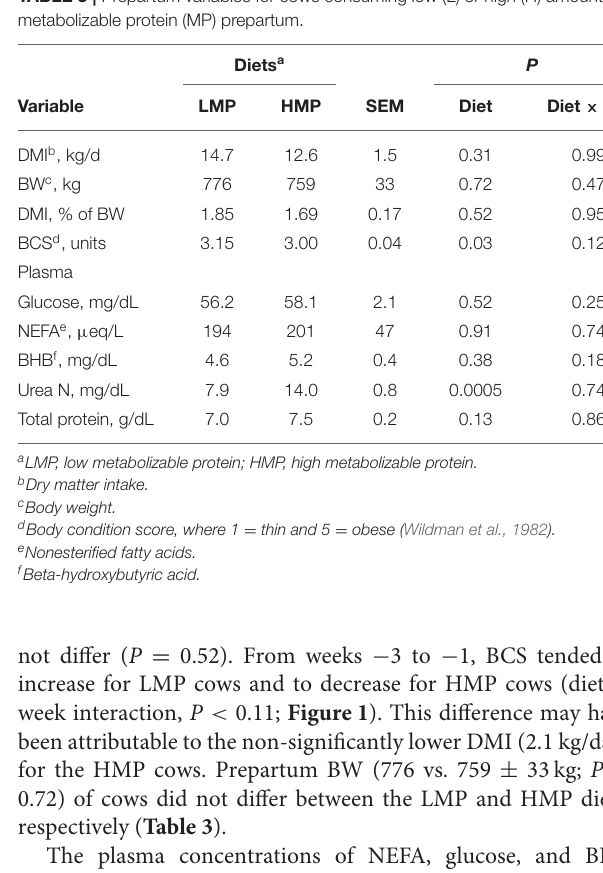
( Table 3 ) did not differ between diets ( P = 0.91, P = 0.52, and